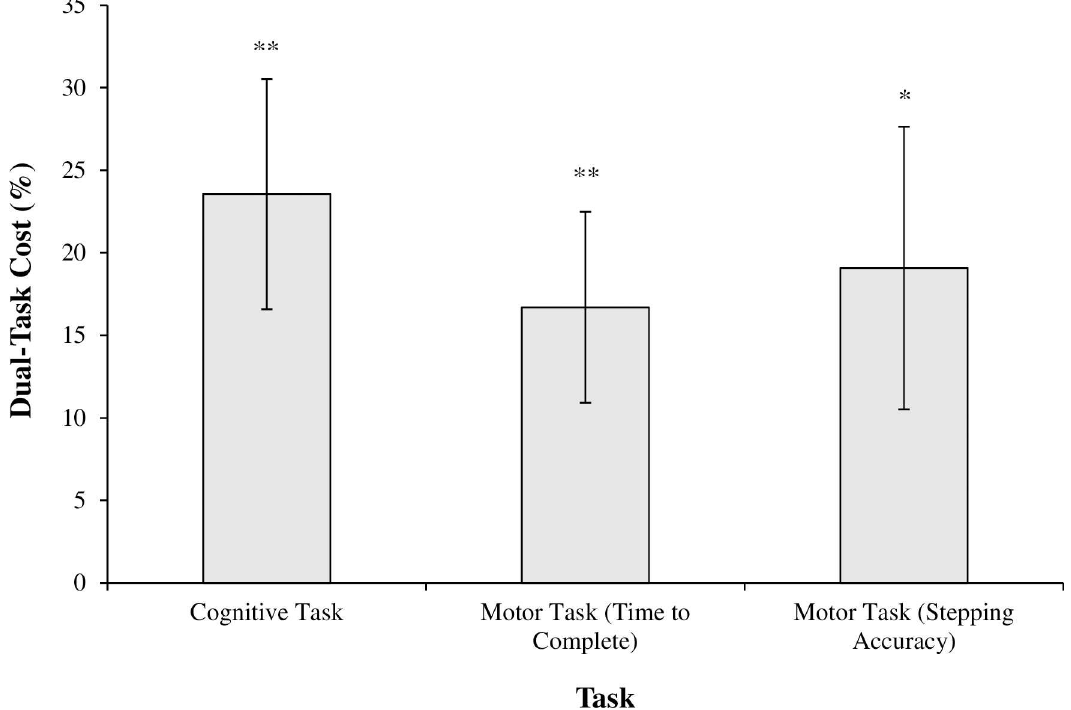
Fig 4. Dual-task costs (as a percentage decreasein performance compared to single-task performance) (mean ± standard error of the mean), * p < .05, ** p < .01.